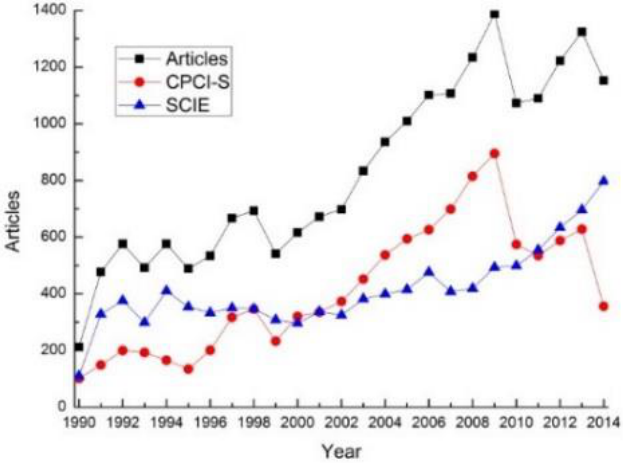
Figure 2. Temporal patterns of artificial intelligence-related articles. Table 1. Summary scientific outputs from 1990–2014.